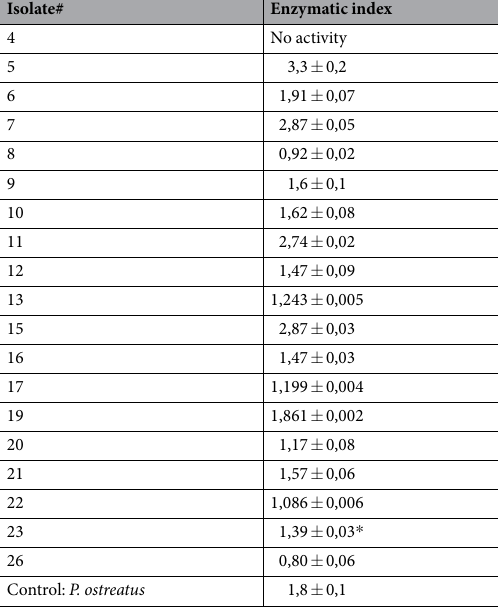
Table 2. Enzymatic indices of the isolates on CMC agar stained with Gram Iodine after incubation for seven days. * EI was measured after 24